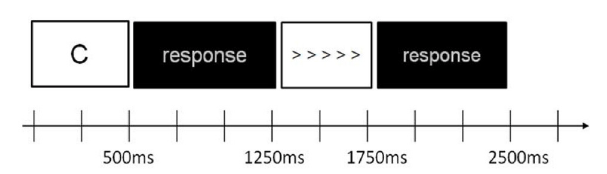
FIGURE 1 | Schematic of stimulus sequence and timing of the n-back task with flanker stimuli for 1